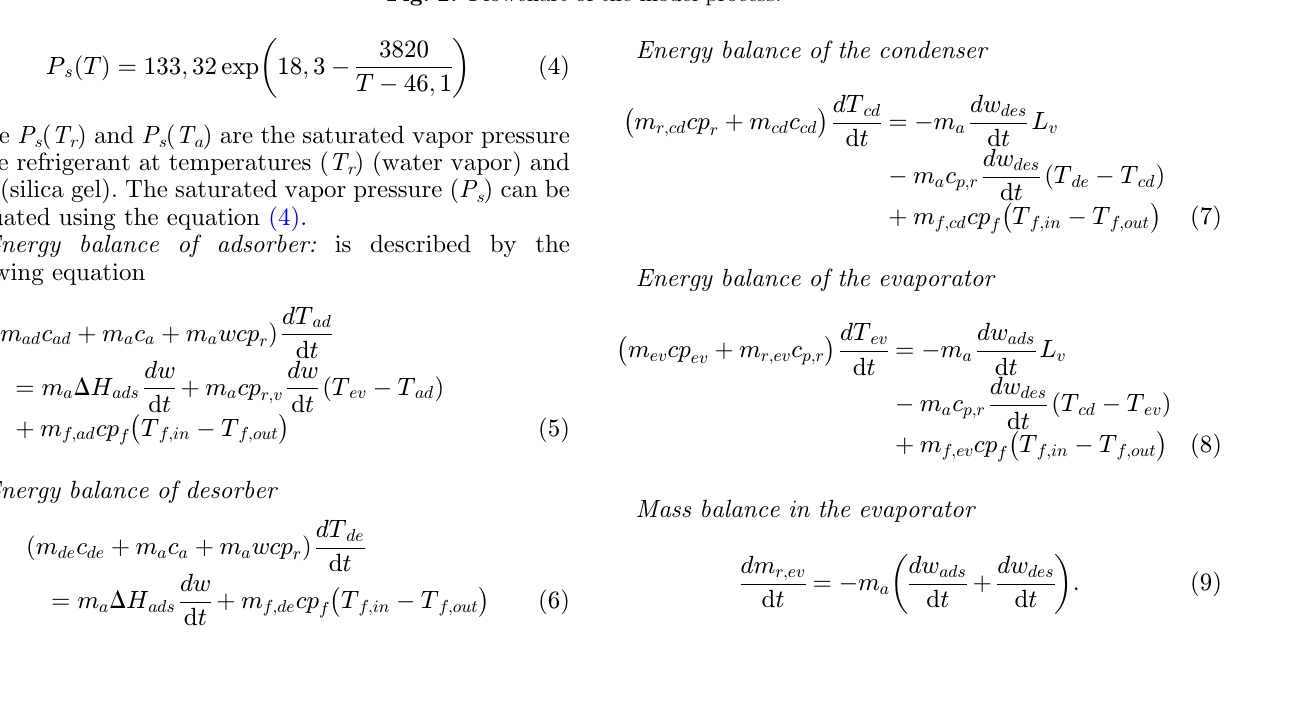
Fig. 2. Flowchart of the model